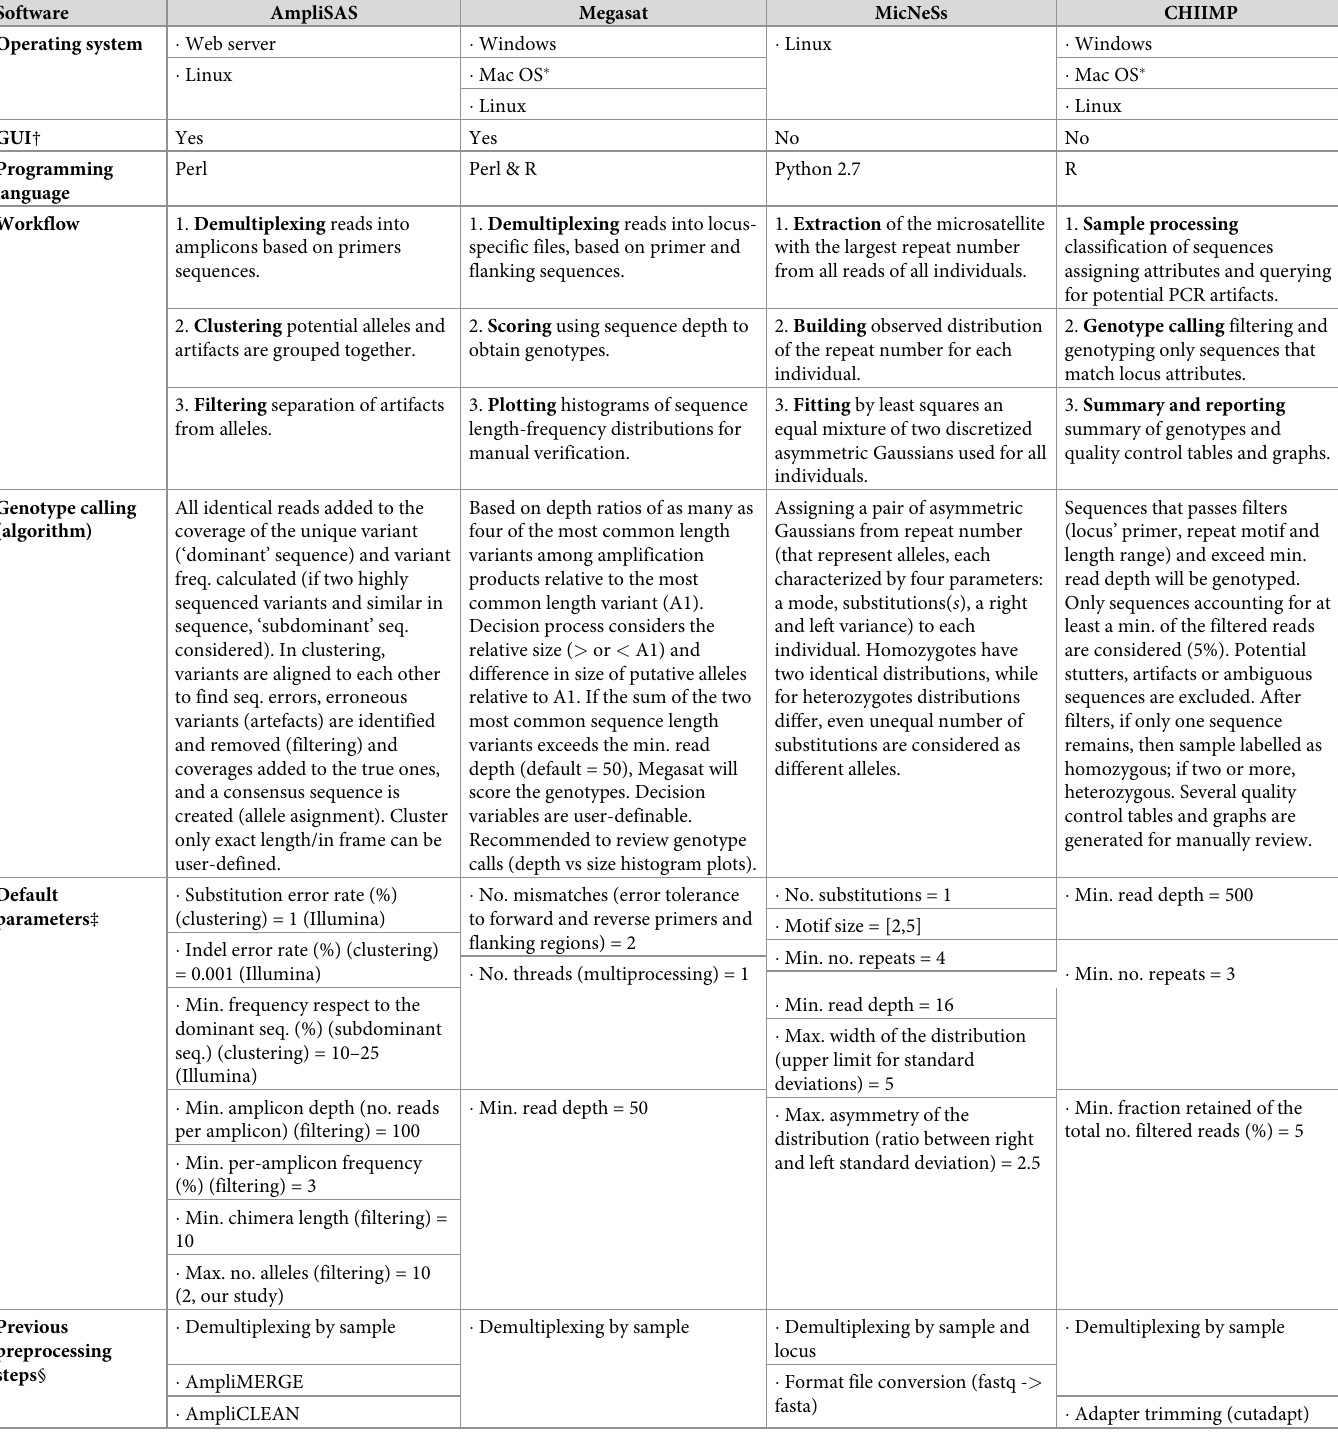
Table 1. Summary of program properties. Description of programs compared in this study, including an outline of the workflow, default parameters, important features, and brief observations on the ease of use.